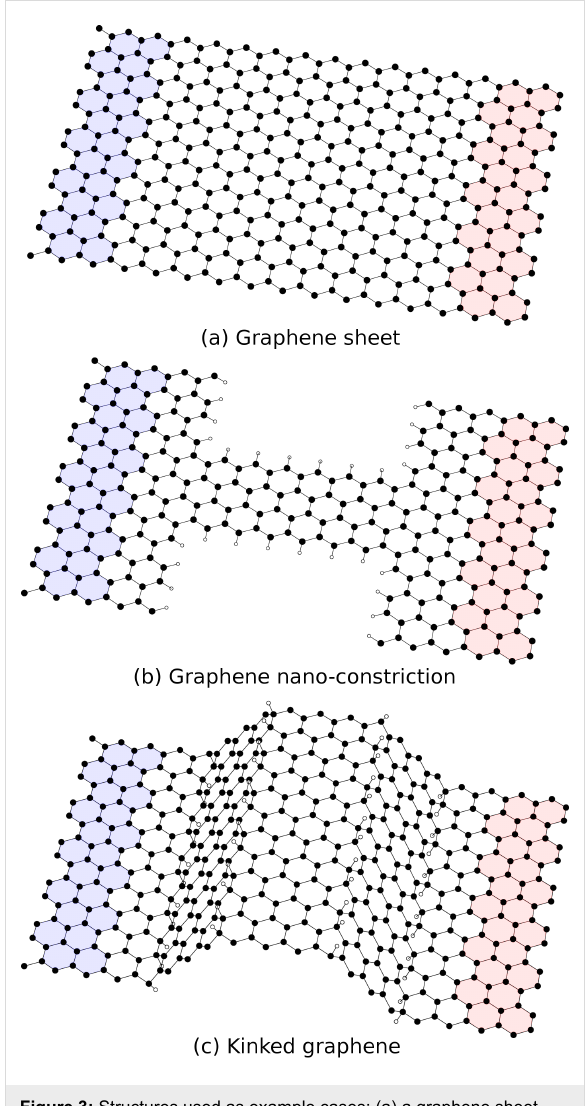
Figure 3: Structures used as example cases: (a) a graphene sheet consisting entirely of carbon atoms, (b) a graphene hydrogen-passi- vated nano-constriction, and (c) a kinked graphene sheet decorated with hydrogen along the kink lines. The left and right electrodes have been highlighted with blue and red, respectively. Minimal unit-cells in the transverse transmission direction have been used due to the peri- odicity. Carbon atoms are shown in black, while hydrogen atoms are shown in